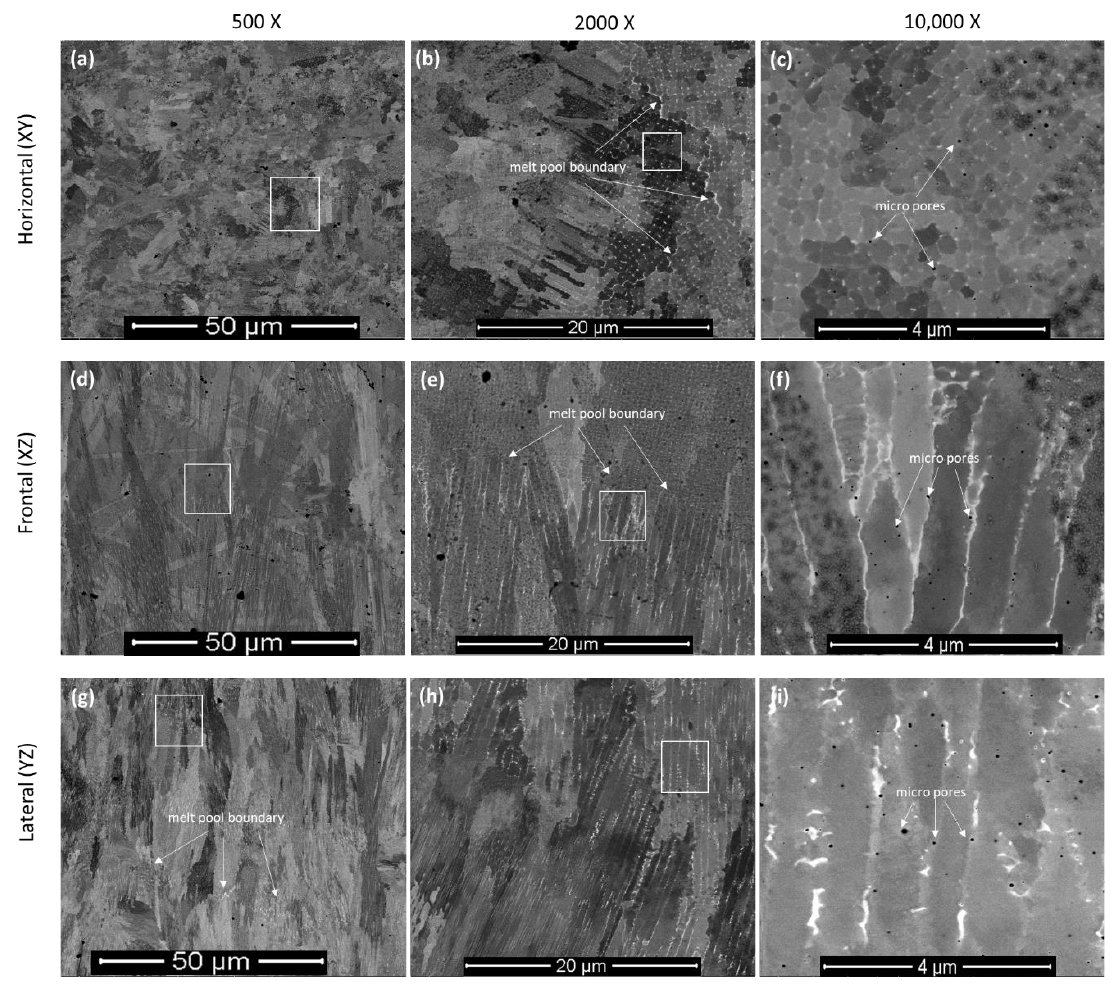
Figure 2. SEM micrographs of the P-LBF-processed Inconel 718 after metallographic polishing, at different magnification, on: ( a – c ) horizontal, ( d – f ) frontal and ( g – i ) lateral in relation to the build direction. The white boxes indicate the areas from where the higher magnification images were ob- tained.